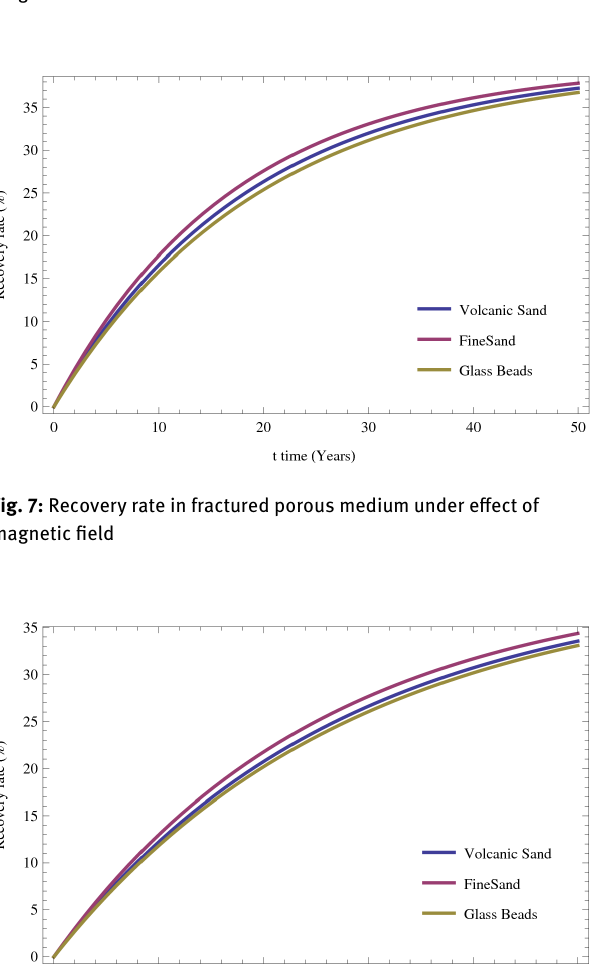
Fig. 6: Recovery rate in matrix porous medium without effect of magnetic field